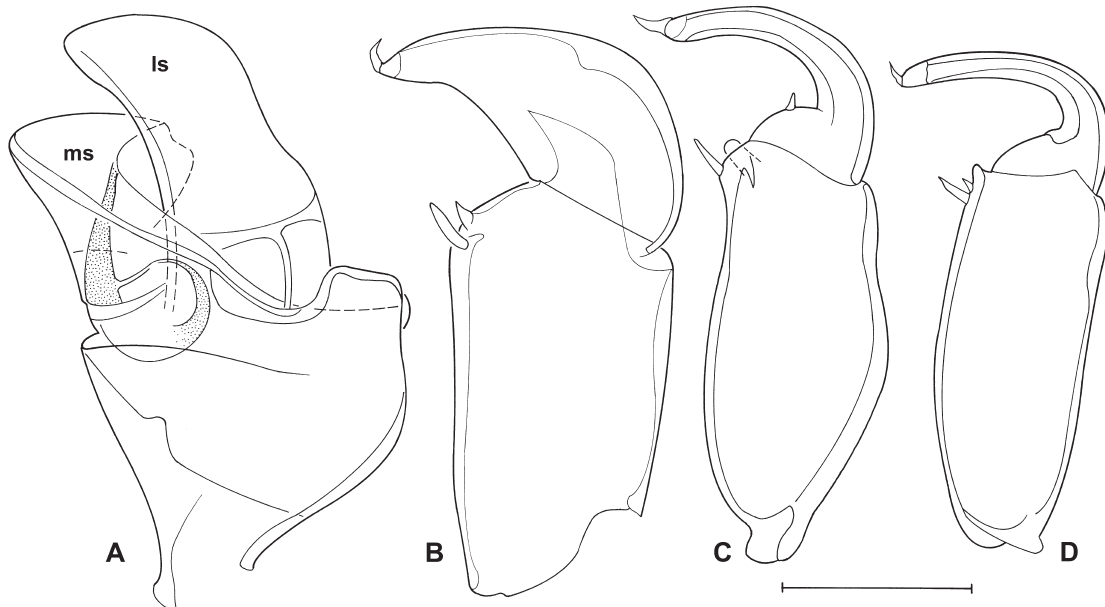
Fig. 22. Bennelongia strellyensis sp. nov. (all from Strelley Station, Pilbara, type locality; ♂; A-C = holotype ♂, WAM.C49419; D=OC.3321). A . Hemipenis outline. B . right prehensile palp. C .